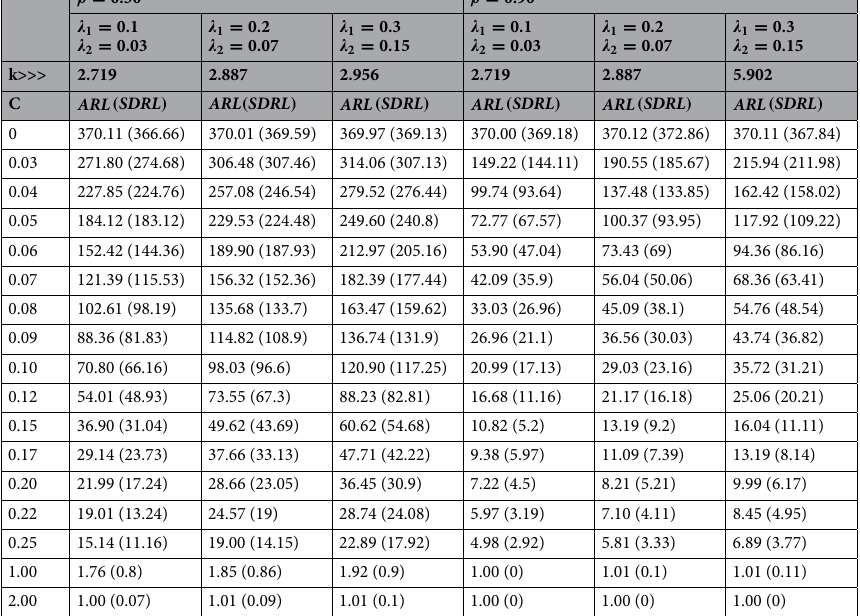
Table 2. ARLs of EEWMA-RE control chart when ARL 0 = 370, n = 5 .